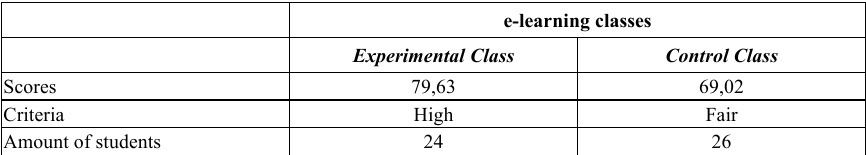
Table 4. Mean Scores of the e-learning posttest